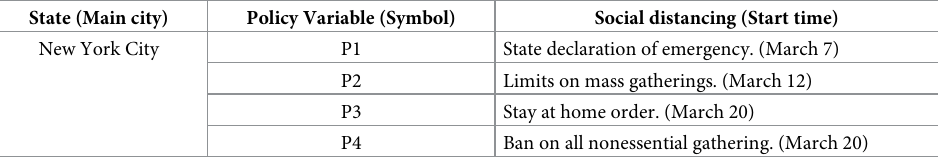
Table 2. Public policies ordering COVID-19 community mitigation interventions and dates of issuance in New York City, February 26-May 30, 2020.